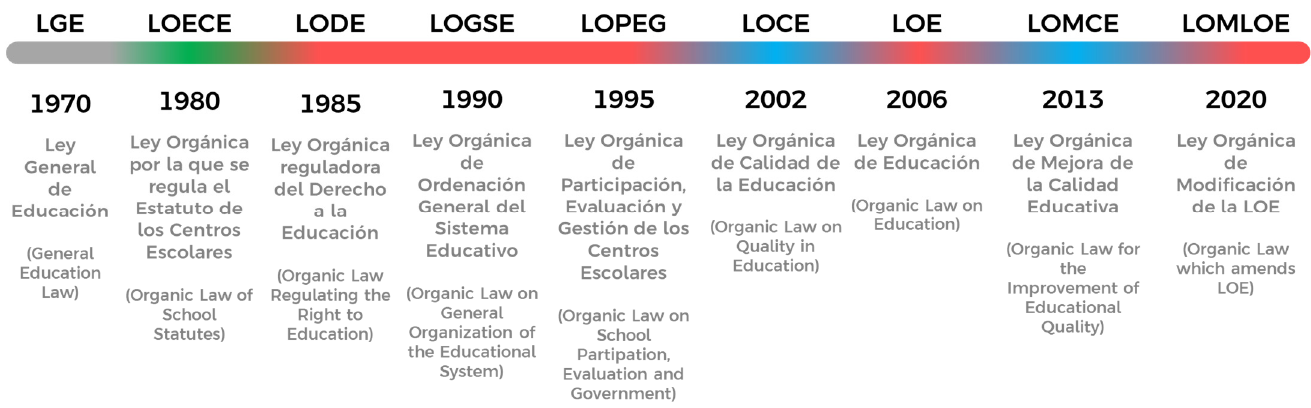
Figure 1. Spanish educational laws in the last half century. Own preparation.